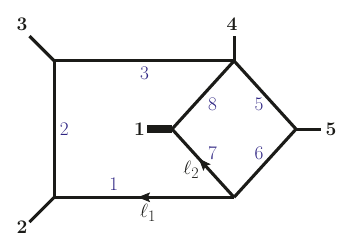
Figure 3. Penta-box with 6 master integrals.